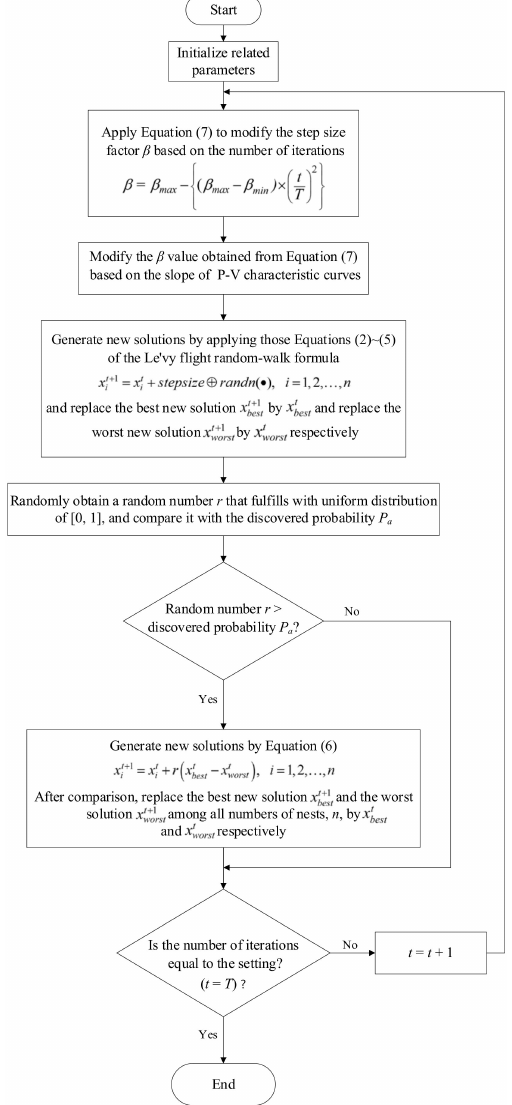
Figure 2. Flowchart of the maximum power point tracking based on the improved cuckoo